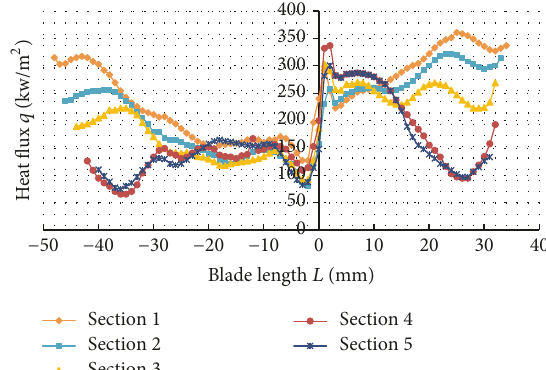
Figure 9: Heat flux in sections of blade obtained by averaging over three prototypes, 𝑃 𝑏 /𝑃 0 =